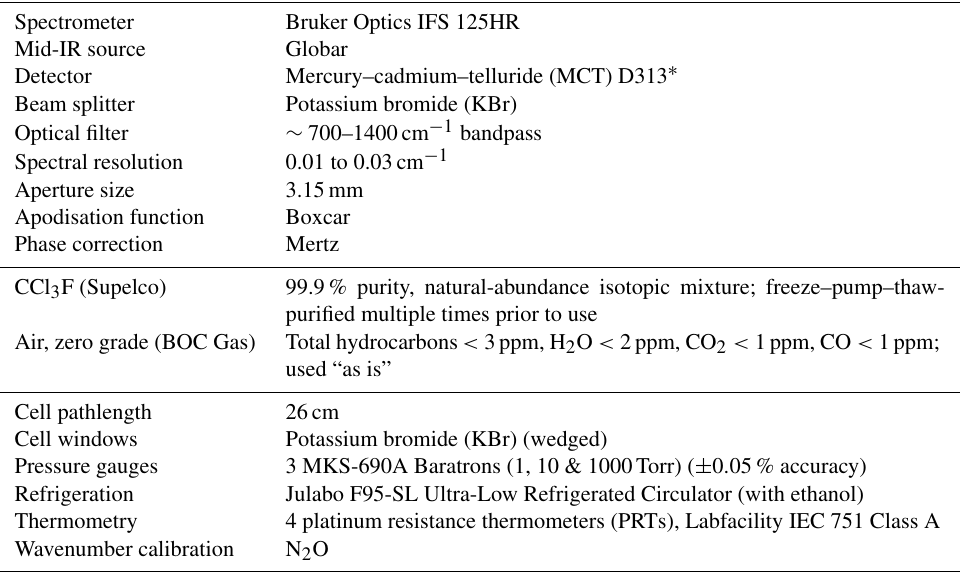
Table 2. FTS parameters, sample conditions, and cell configuration for all measurements.